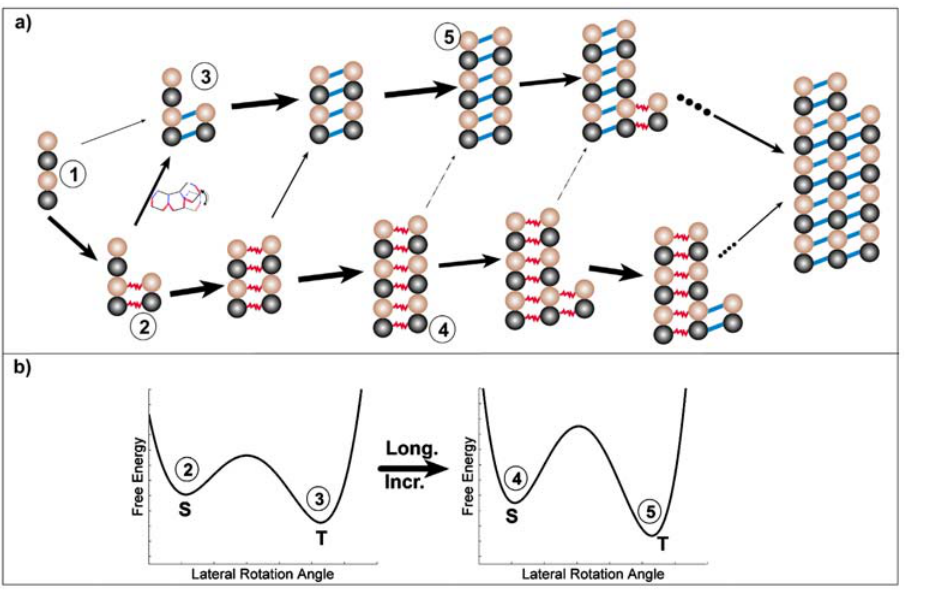
Figure 7. Schematic illustration of how two PFs could form sheet bonds fast and then be kinetically trapped. (a) Illustrative pathways of the assembly process showing a kinetic trap. (b) Schematic illustration that formation of additional sheet bonds increases the transition barrier to the thermodynamically more stable tube bonds.